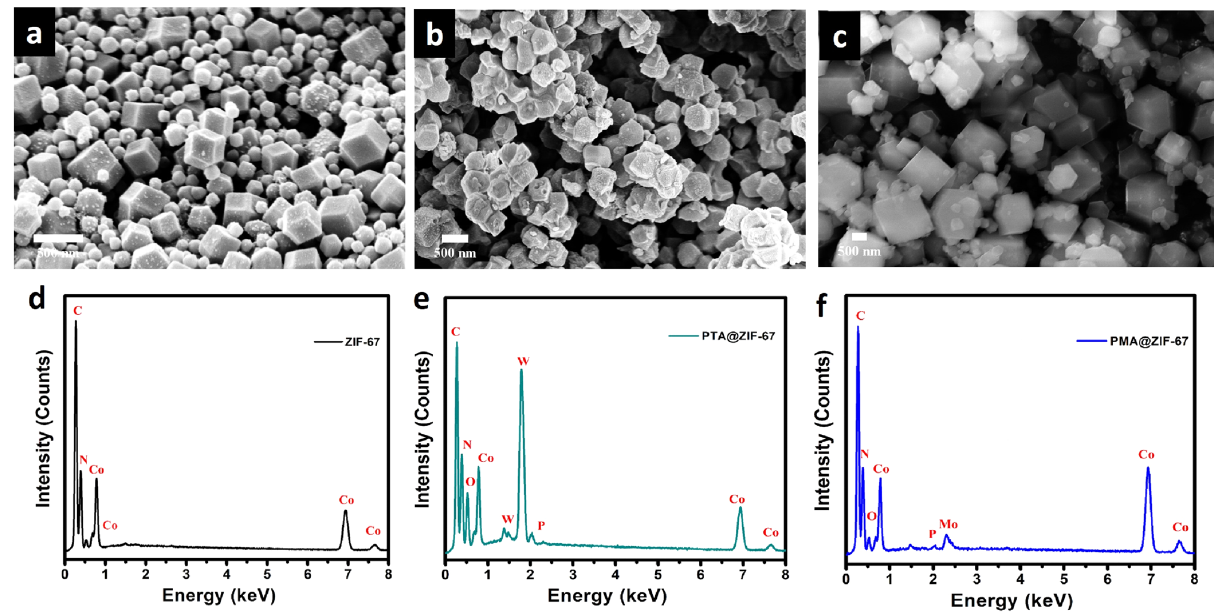
Figure 2. FESEM top view images of the as-synthesized ( a ) pure MOF, ( b ) PTA@ZIF-67, ( c ) PMA@ZIF-67 ( d ) the corresponding EDS spectra of pure MOF, ( e ) PTA@ZIF-67, and ( f ) PMA@ZIF-67.